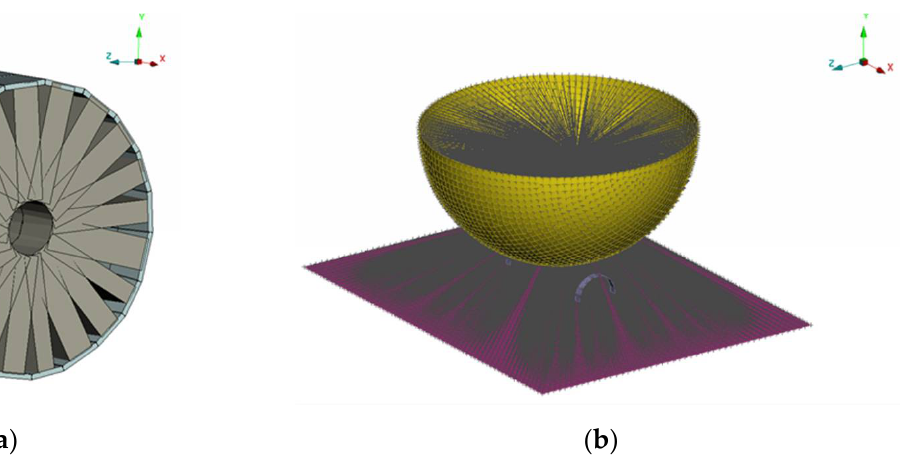
( b ) Figure 11. Section comparison scanned deformed battery vs CAD data ( a ) first specimen section results and ( b ) second specimen section results. 3.2. FE Model Build Up and Simulation Results The simulation of the model was performed with the LS DYNA solver and is pre- sented in Figure 12. The battery model has two parts: one shell for the case, and one for the interior with the above presented materials. These shells are made of elements with a medium size of 3 mm. The size is important to keep the time step low without adding mass to the model; in this case, close to 0 mass was added. Time step is influenced by the size of the element and the density of the element material. The part of the battery con- tained 465 hexa (94.7%) and 26 tria (5.3%) elements. For the jelly roll shell, the numbers were 422 hexa (97.25%) and 14 tria (2.75%) elements. The pendulum ball was modeled out of rigid shells. In this case, the plate in the model was considered un-deformable, as it was also made by ideal rigid shells. This method of modeling was chosen due to the complexity of measuring the real stiffness of the place where the battery was fixed, which was in the middle of the plate in the front of the pillar